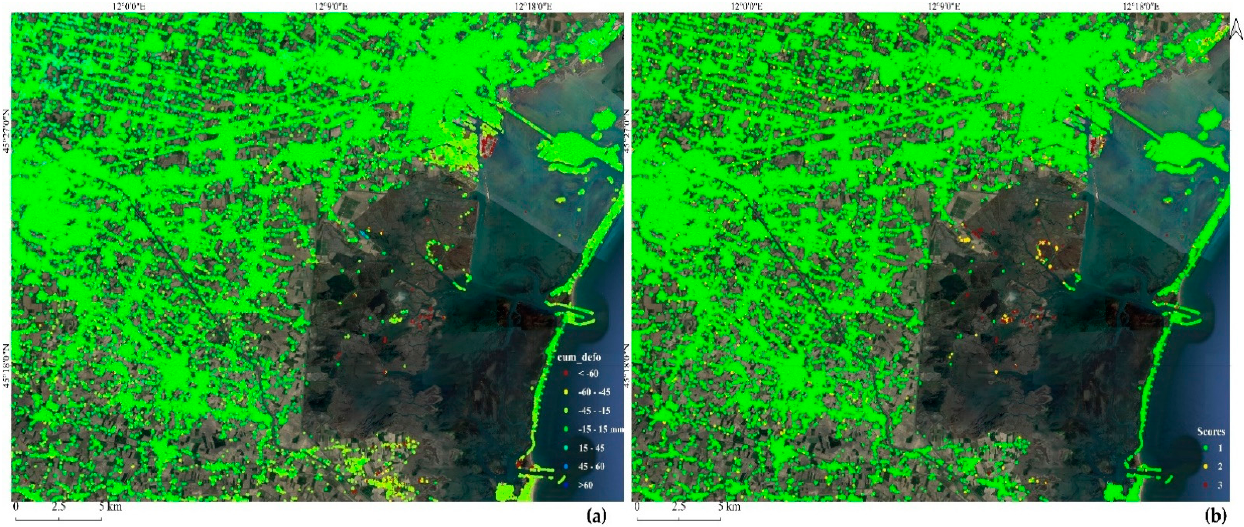
Figure 6. A comparison of geocoded cumulative phase information at the final image (a) with the quality scores (b) for the PSs taken from the sub-area of Venice lagoon, Italy.